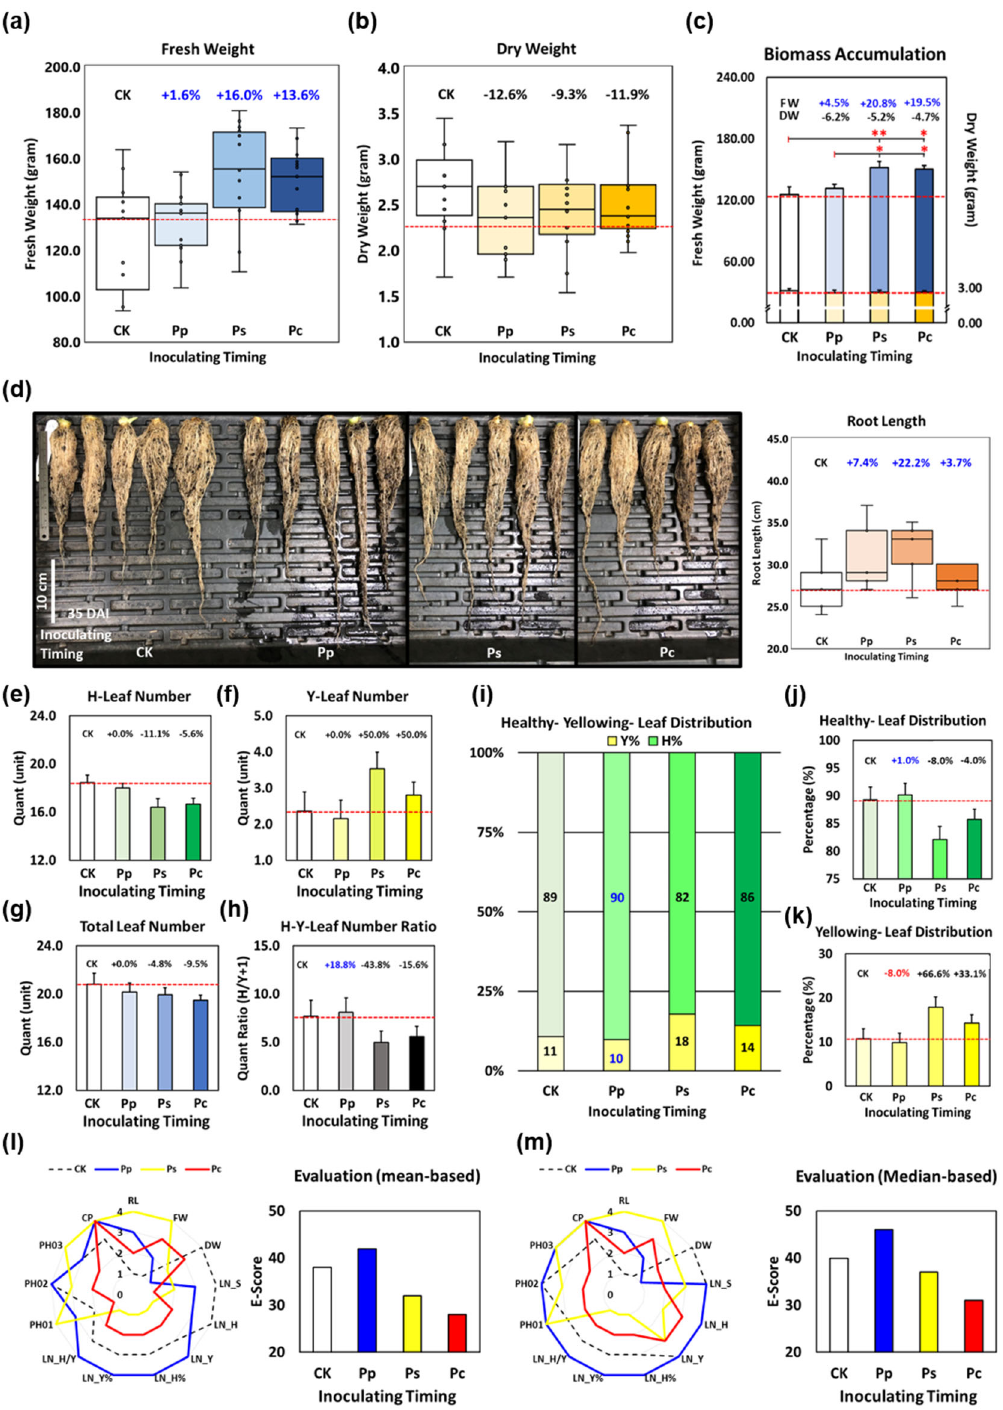
Figure 2. Effects of endophytic inoculation timing on lettuce growth in the greenhouse. The endophytic inoculation (concentration: OD 600 = 1.0) was performed at the following stages: 4- to 5-leaf stage seedlings in plug cells (Pp), seedlings transplanted into plastic pots for one week (Ps), and plants in plastic pots that reached precupping (Pc); water inoculation was set as the control (CK). The lettuce seedlings were harvested in the precupping growth stage, and all phenotypes were recorded 35 days after inoculation (DAI). ( a ) Median fresh and ( b ) dry weight; ( c ) biomass accumulation based on the mean fresh and dry weight. The ( d ) root length (left chart) and phenotype (right image); n = 5. The ( g ) total leaf number and shoot health indexes: ( e ) healthy leaf number, ( f ) yellowing leaf number, ( h ) healthy and yellowing leaf number, and ( i – k ) healthy and yellowing leaf distribution. The overall evaluation of the indexes’ e ff ects on seedling growth was